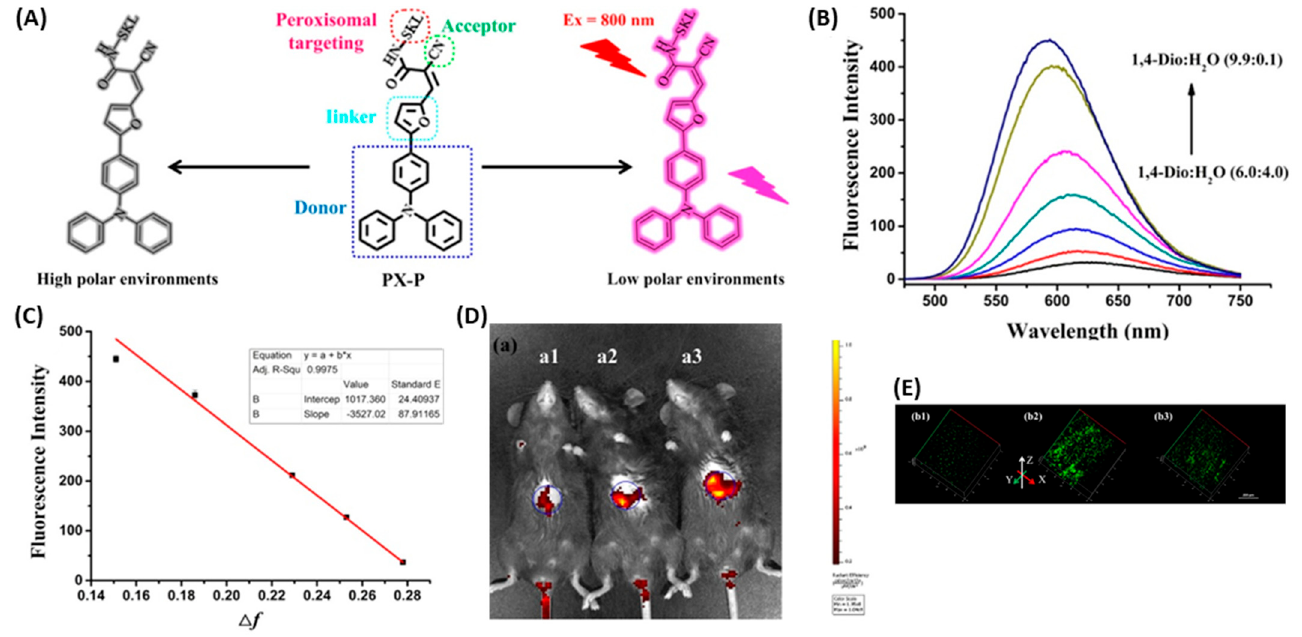
Figure 13. ( A ) Structure of PX − P and the proposed response mechanism to polarity. ( B ) Fluorescence of PX − P (5.0 μ M) in various 1,4-Dio–H 2 O solvent systems. ( C ) Linear relationship between fluorescence intensity of PX-P (5.0 μ M) and Δ f in various 1,4-Dio–H 2 O solvent systems. λ ex = 460 nm and λ em = 586 nm. ( D ) Liver fluorescence imaging of PX − P (100 μ L, 10–4 M) in vivo. ( E ) Two-photon imaging of PX − P in livers of mice with NAFLD. [43] Copyright © 2023 American Chemical Society.